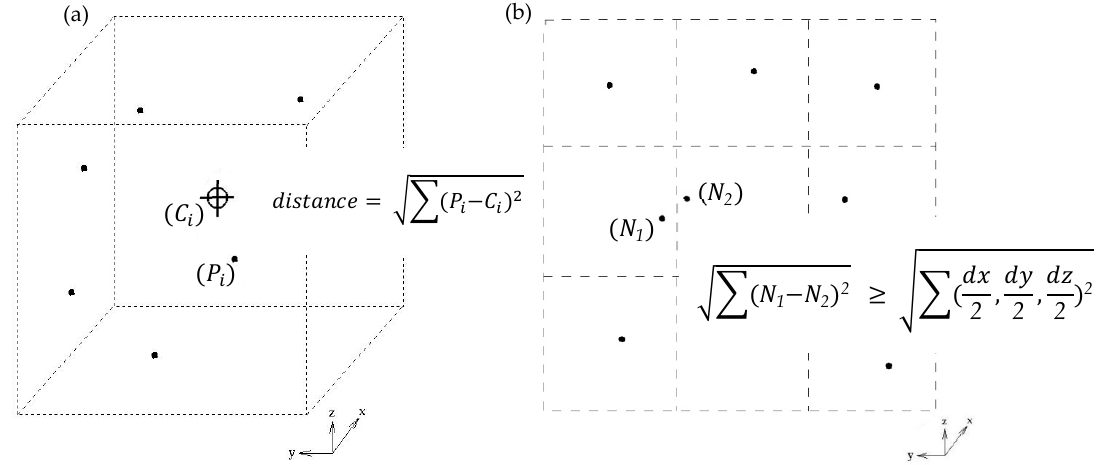
Figure 5. ( a ) A diagrammatic representation of a cell and the node structuring scheme where only the node P i (i 1 ,j 1 ,k 1 ) closest to the center of the cell C i (i 2 ,j 2 ,k 2 ) is saved; ( b ) A diagrammatic representation of the conformity scheme for several cells, each with dimensions dx , dy and dz , where the nodes N 1 (i 1 ,j 1 ,k 1 ) and N 2 (i 2 ,j 2 ,k 2 ) are checked against the conformity criterion.